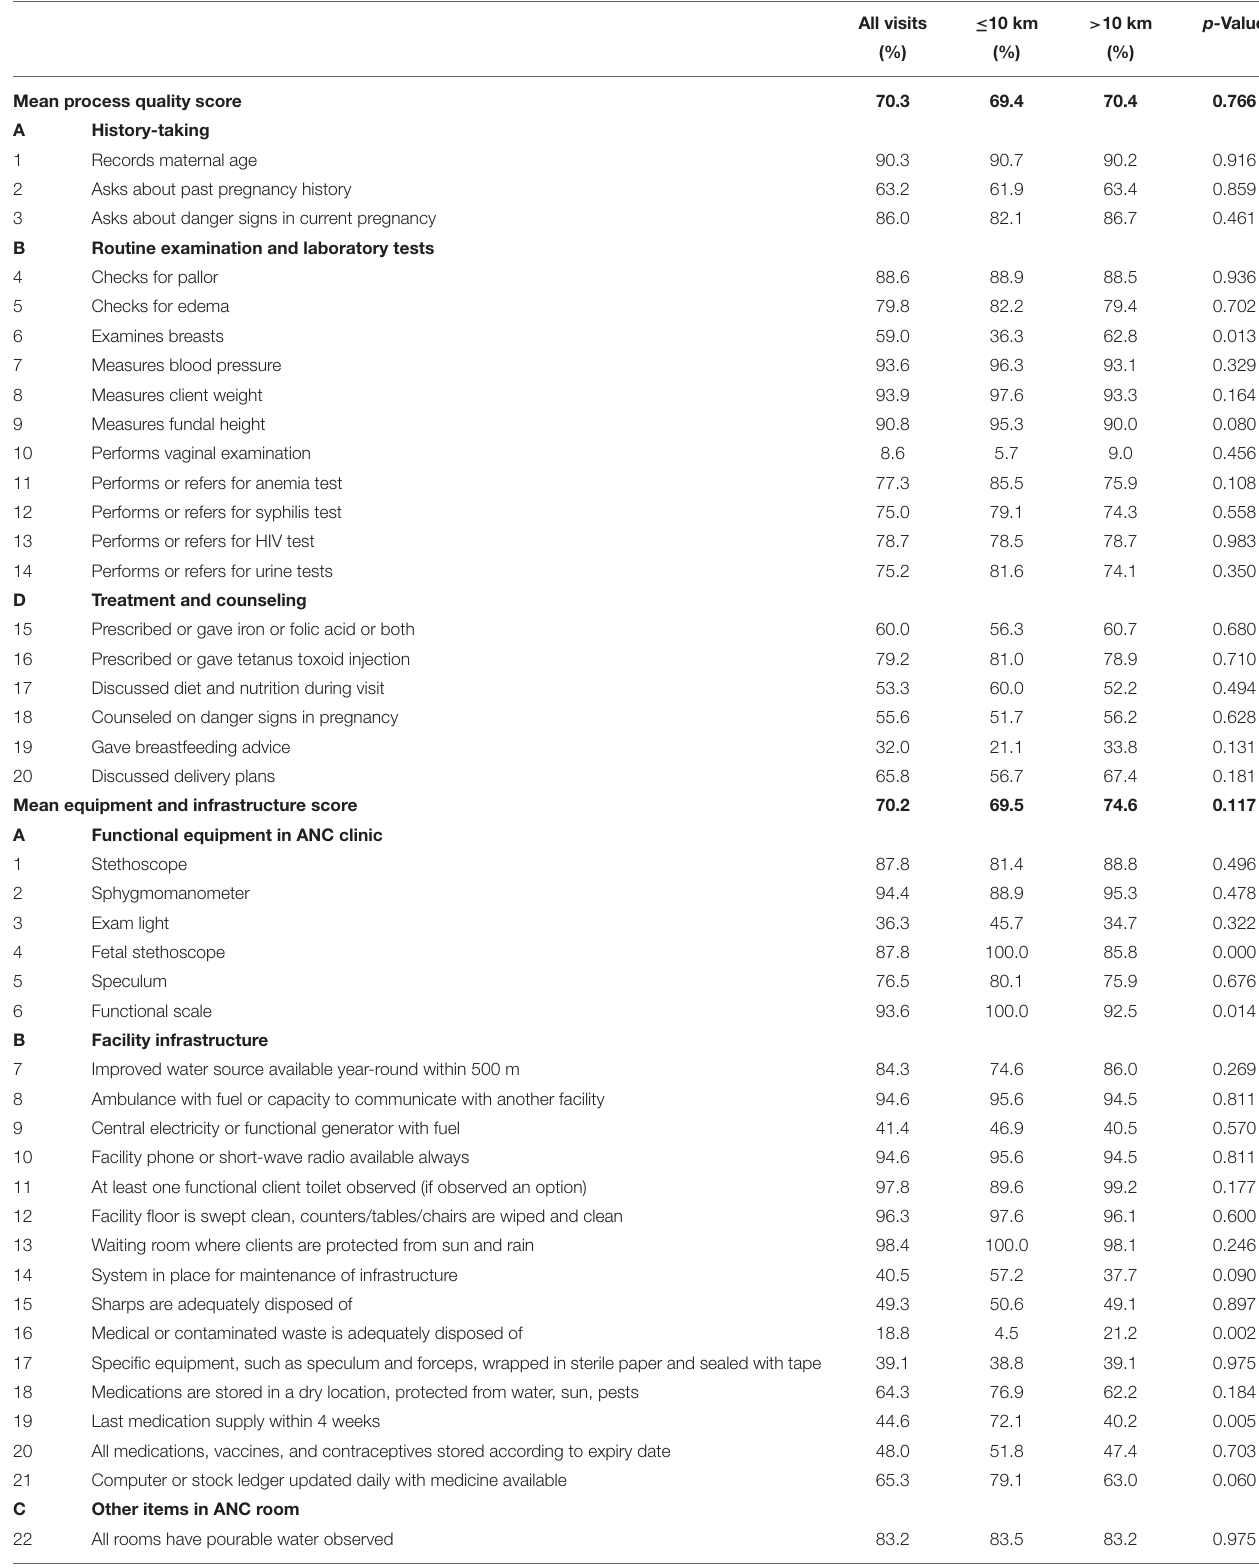
TABLE 8 | Variation in ANC quality by facility exposure to